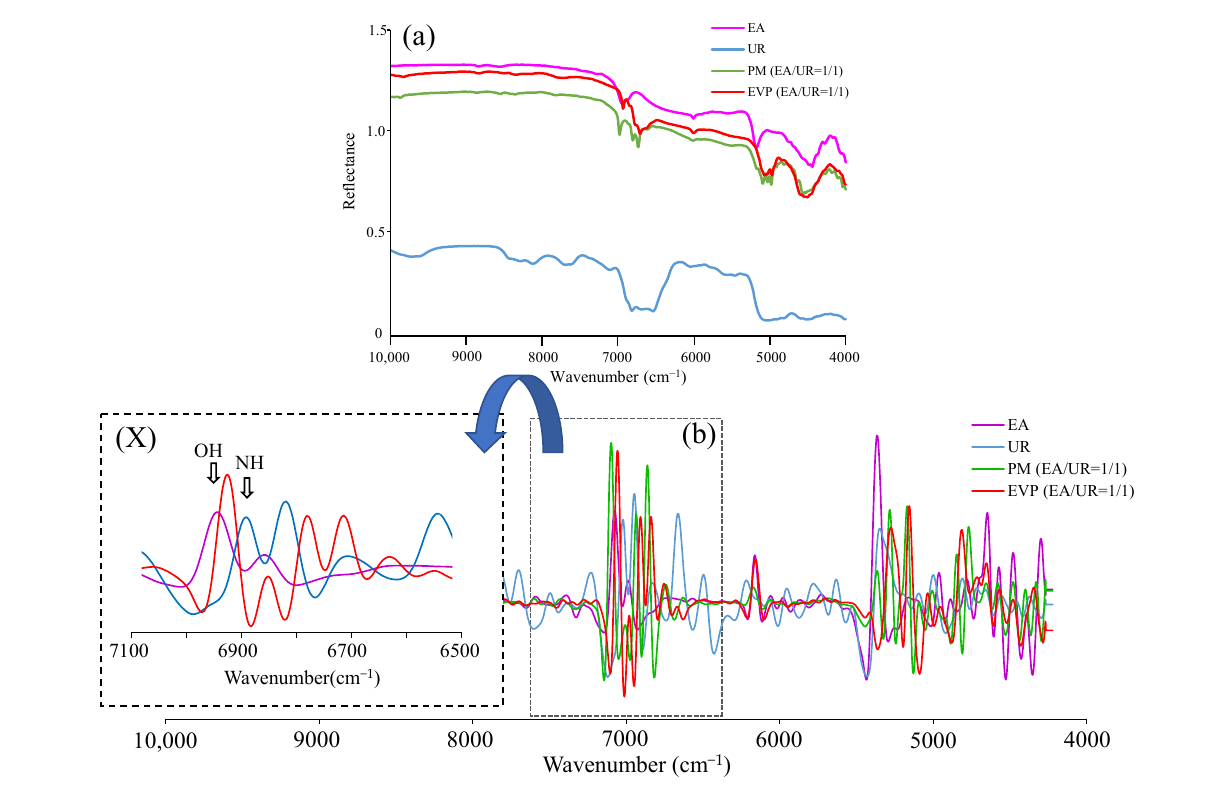
Figure 8. ( a ) NIR absorption spectra of EA/UR systems observed at 4000–10,000 cm − 1 ; ( b ) second derivative NIR absorption spectra of EA/UR systems observed at 4000–10,000 cm − 1 ; and ( X ) second derivative NIR absorption spectra of EA/UR systems observed at 6500–7100 cm − 1 .